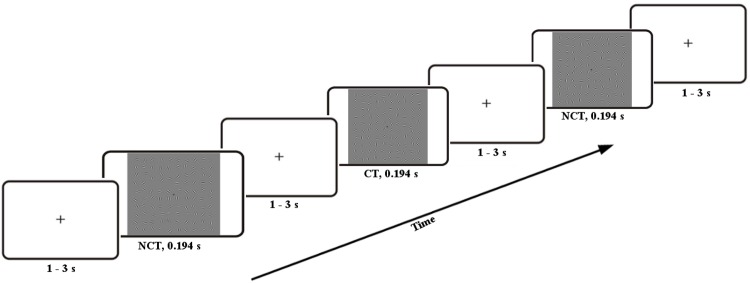
Stimulus protocol including Gabor patches either forming a contour (CT) or none (NCT).